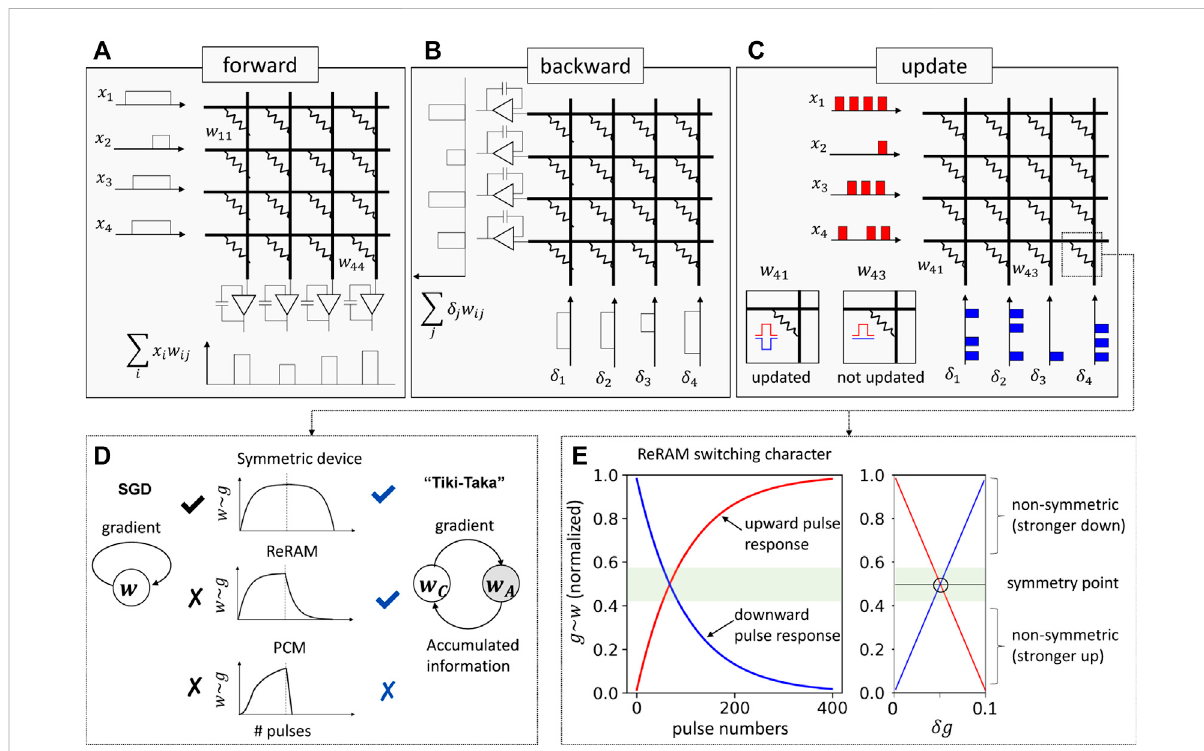
FIGURE 1 Schematics for RPU array describing (A) forward pass, (B) backward pass, and (C) update pass. The update procedure utilizes the stochastic gradient descent algorithm where the randomized pulse sequences are sent to rows and columns. Those cells where the pulses coincide get updated (e.g., w 41 ). Otherwise, the cell is not updated (e.g., w 43 ) (Haensch et al., 2019). (D) Schematics of ideal device characters, which have a bidirectional switching response and are symmetric to the negative/positive switching pulses. Such a character is suitable for SGD algorithm. However, the realistic device character is different. ReRAM shows a bidirectional but nonsymmetric switching character, and PCM exhibits unidirectional with a highly nonsymmetric switching character. Those are not suitable for the SGD algorithm, but the modi fi ed SGD ( Tiki-Taka ) algorithm can accommodate ReRAM-like switching characters (Gokmen and Haensch, 2020). (E) Typical ReRAM conductance response to the multiple voltage pulses. The red line depicts the response to the upward pulse, and blue line describes the response to the downward pulse. The differential conductance shown on the right panel of (E) describes the symmetry point where the conductance changes to the upward/downward response are